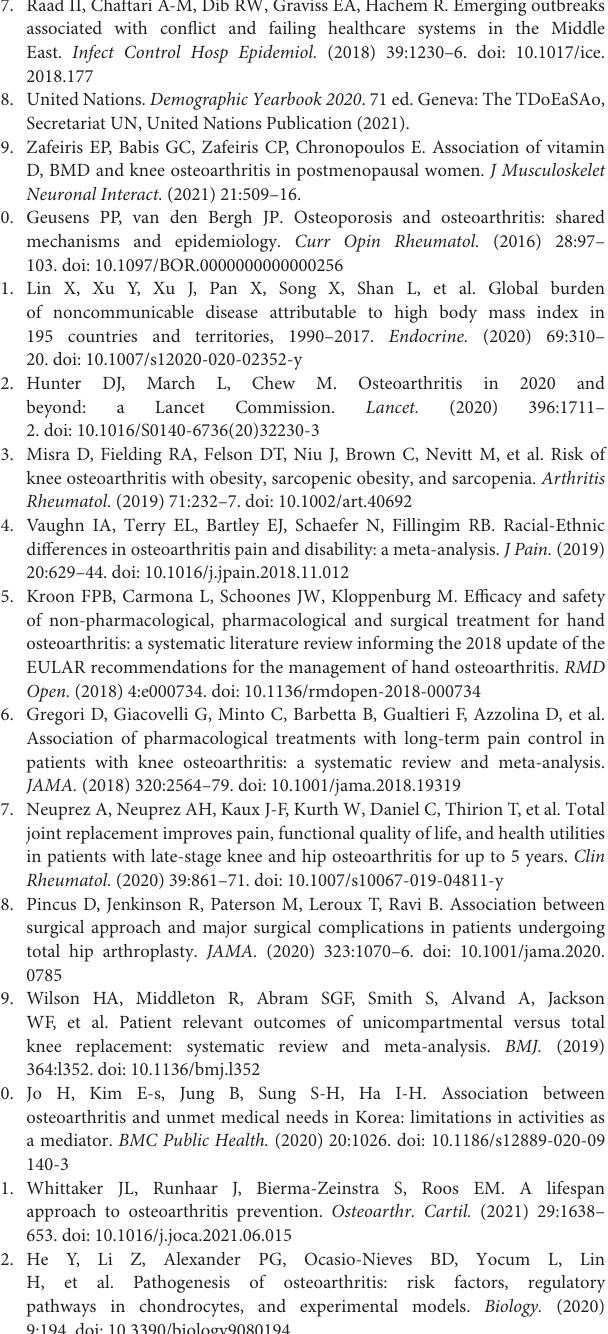
Supplementary Table S2 | Incidence of osteoarthritis in 1990 and 2019 for both sexes and percentage change in age-standardized rates (ASRs) per 100,000 in the North Africa and the Middle East region (generated from data available from http://ghdx.healthdata.org/gbd-results-tool). Supplementary Table S3 | YLDs due to osteoarthritis in 1990 and 2019 for both sexes and percentage change in age-standardized rates (ASRs) per 100,000 in the North Africa and the Middle East region (generated from data available from